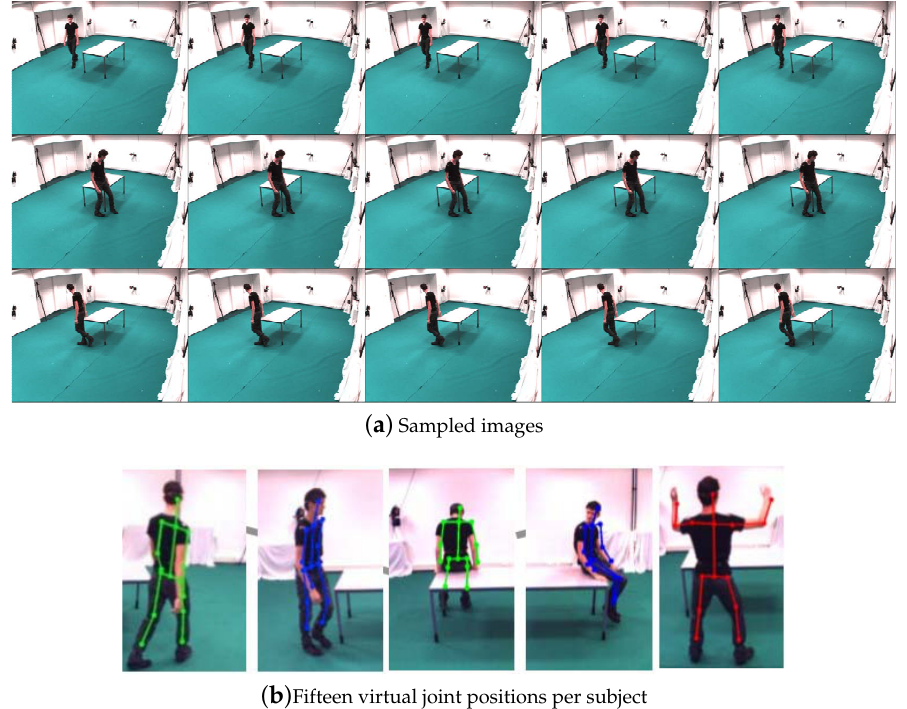
Figure 5. Sample images and marker information from the UMPM dataset